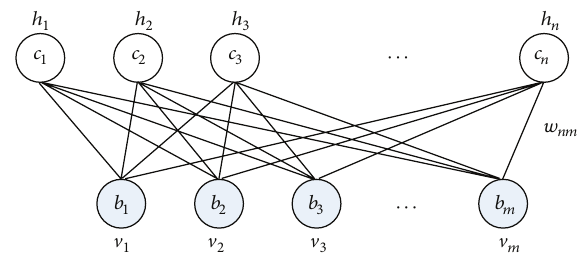
Figure 2: Architecture of an